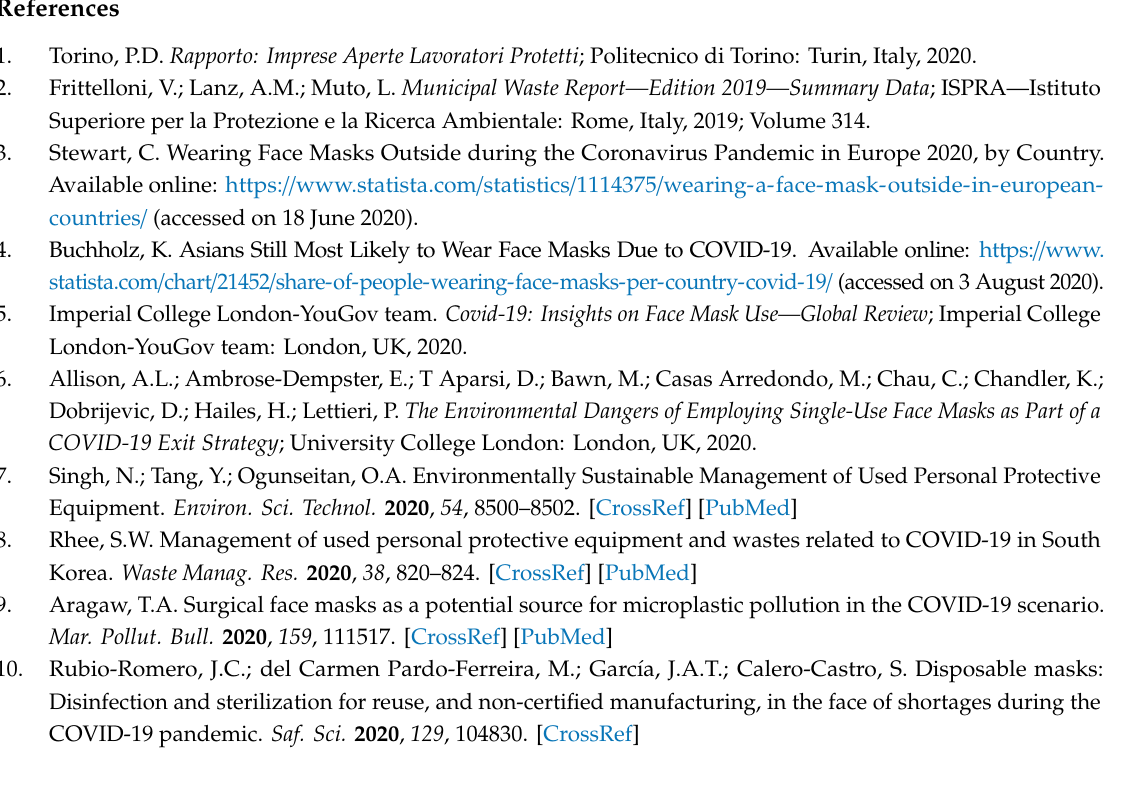
Figure S1: EDX of EL_Type I and EL_Type II, Figure S2: EDX of NW, Figure S3: ATR of the surface of the